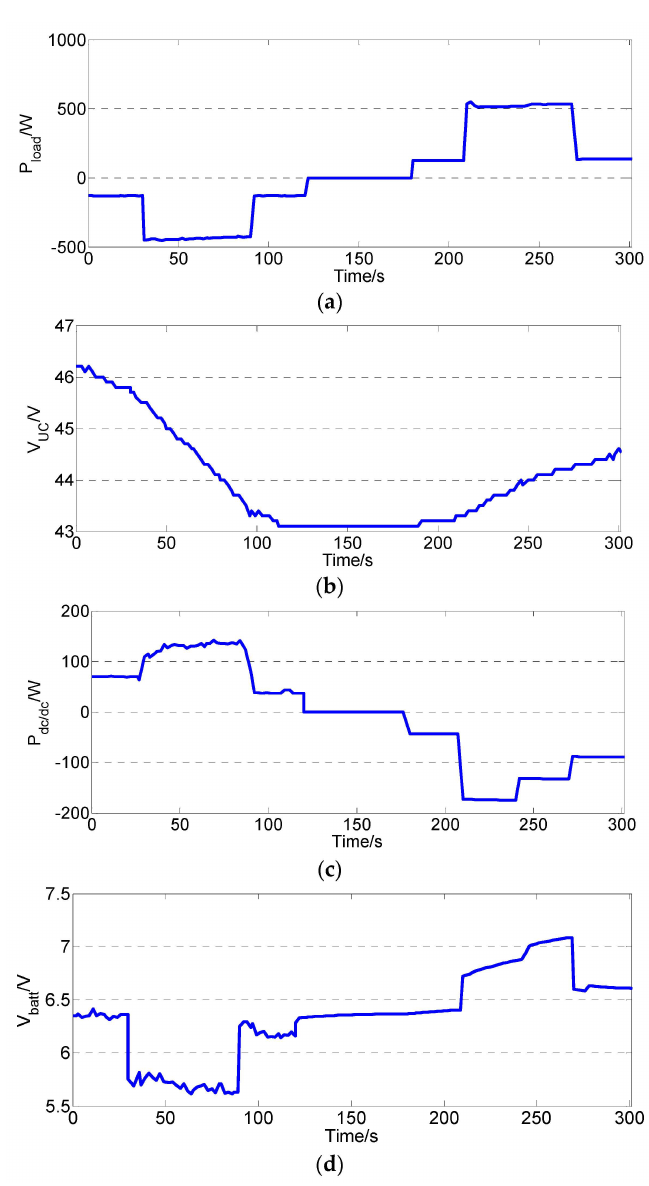
Figure 28. The experimental results when the UC bank voltage is higher than 40 V. ( a ) Power of the load; ( b ) Voltage of the UC bank; ( c ) Power of the bi-directional dc/dc converter; ( d ) Voltage of the battery